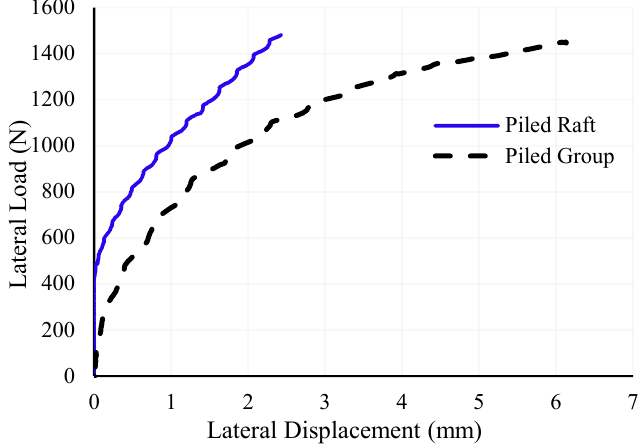
Figure 26. 21-piled raft vs. 21-pile group response under lateral load.